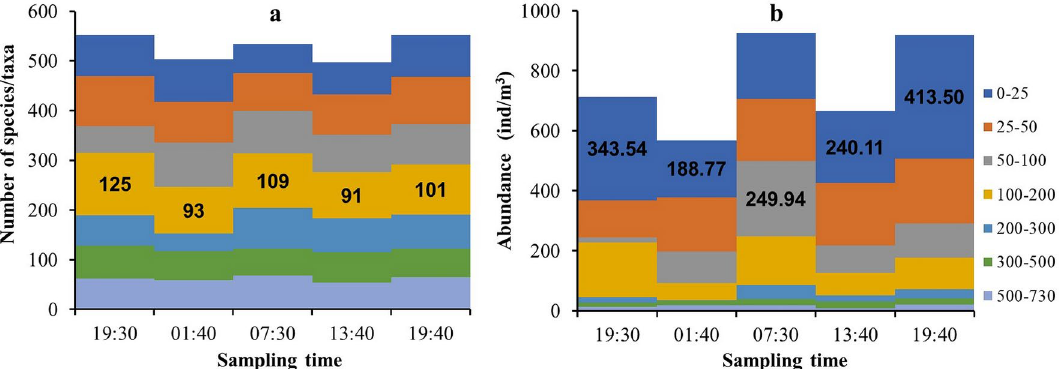
Figure 2. The diel vertical variations of zooplankton species/taxa ( a ) and abundances ( b ) in the Caroline Seamount area on June 2 to 3, 2019. The data label in bold black font indicates the highest (DCM) layer was detected at 100–120 m. The DO increased slightly from the sea surface to a depth of 100 m and decreased rapidly from 100 m to the deeper layer. The oxygen minimum zone (OMZ) was found in the 300–400-m layer, and the lowest DO was less than 3.0 mg/L (Fig. 1). Species composition and diversity of the zooplankton community. From June 2 to 3 2019, we collected and identified 346 zooplankton species/taxa in the Caroline Seamount area, including 163 species of Copepoda, 36 species of Cnidaria, 32 species of pelagic ostracods, 26 taxa of pelagic larvae, 21 species of Amphi- poda, 16 species of Chaetognatha, 12 species of Euphausiacea, 12 species of tunicates, 12 species of planktonic pteropods, 4 species of Polychaeta, 3 species of Decapoda, 3 species of Heteropoda, 2 species of Mysidacea, 2 species of Ctenophora, 1 species of Isopoda, and 1 species of Cladocera. The Sørensen’s coefficient of similarity ( SCS ) values between the five sampling times were high, ranging from 71.1 to 80.8%, and the average SCS of all zooplankton communities sampled was 76.00%. Therefore, the five zooplankton samples collected at different times can be regarded as belonging to the same zooplankton community of the Caroline Seamount area. The numbers of species/taxa collected throughout the water column at the five sampling times (19:30, 01:40, 07:30, 13:40, and 19:40) were 247, 211, 215, 201, and 217, respectively. There were 127 common species/taxa among the five sample collections. At each sampling time, the 100–200-m layer had the highest numbers of zoo- plankton species/taxa. The diel vertical variation in zooplankton species/taxa was not obvious, but the number of zooplankton species/taxa collected from the whole water column was lowest at 13:40 and highest at 19:30 (Fig. 2a). The total zooplankton abundances for the whole water column at the five sampling times (19:30, 01:40, 07:30, 13:40, and 19:40) were 54.72, 40.88, 71.49, 48.79, and 71.33 ind/m 3 , respectively. However, the distribu- tion of the highest species/taxa number and abundance in different water layers showed different trends. For all sampling times except 07:30, the highest abundance was found in the 0–25-m layer (Fig. 2b). The highest values of zooplankton community diversity did not coincide with those of zooplankton abundances. The Shannon–Wiener index ( H’ ) of the zooplankton community for the whole water column at the five sam- pling times were 3.93 (19:30), 3.78 (01:40), 3.79 (07:30), 3.77 (13:40) and 3.83 (19:40). The values of H’ increased and then decreased from the surface to the bottom layer. The highest H’ values of the five sampling times were all ≥ 3.50 and occurred in the 100–200-m layer, which was consistent with the location of the thermocline and DCM (Fig. 3). However, the water layer with the highest zooplankton biodiversity was not consistent with the water layer with the highest abundance. Seven dominant species were identified at the survey station. According to the dominance index from high to low, these species were Clausocalanus furcatus ( Y = 0.110), Oithona plumif- era ( Y = 0.100), Clausocalanus arcuicornis ( Y = 0.057), Farranula gibbula ( Y = 0.044), Oncaea venusta ( Y = 0.032), Acartia negligens ( Y = 0.029), and Oncaea media ( Y = 0.027). These dominant species were all small copepods with a body length of less than 2 mm. Vertical distribution of the zooplankton community structure. Among the five sampling times, the proportions of zooplankton above 200 m and 300 m to the total number of zooplankton communities were 78.0% and 84.0%, respectively. A total of 80.0% of zooplankton individuals were distributed in the water layer above 200 m during the nighttime. This proportion decreased to 75.4% during the daytime. However, the pro- portions in the 0–300-m water layer during the nighttime and daytime were similar (84.0% and 83.9%, respec- tively). The proportion above 200 m at the 01:40 sampling time was higher than that at the 13:40 sampling time. According to the location of the OMZ, the seven sampled water layers are grouped into three layers: the upper layer (0–300-m), the OMZ located layer (300–500-m), and the bottom layer (500–730-m). Among the 127 common species/taxa found at the five sampling times, 111 zooplankton species/taxa were mainly distributed in the upper layer, with the highest percentage of the total. More than 80% of the individuals of 89 zooplankton species/taxa were found in the upper layer during the survey period. Furthermore, 34 zooplankton species/taxa were always found in the upper layers and never crossed the OMZ layer during the five sampling times. However, 6 zooplankton species ( Subeucalanus mucronatus , Chirundina streetsii , Nematoscelis atlantica , Lensia multicris- tatoides , Spinocalanus spinosus , and Rhincalanus cornutus ) were mainly distributed in the OMZ located layer.